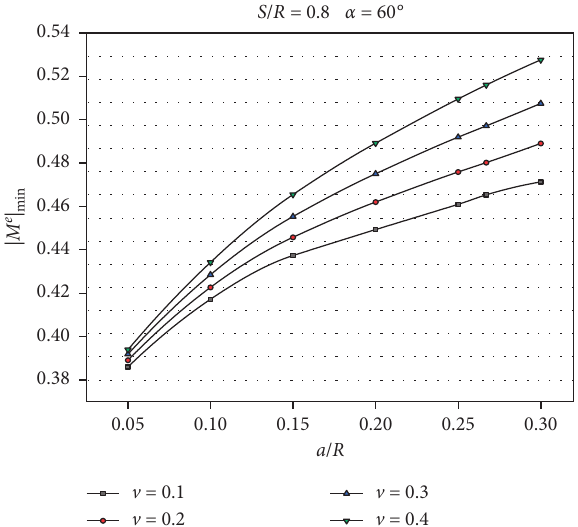
Figure 9: Variations of | M e | min for different values of a / R and